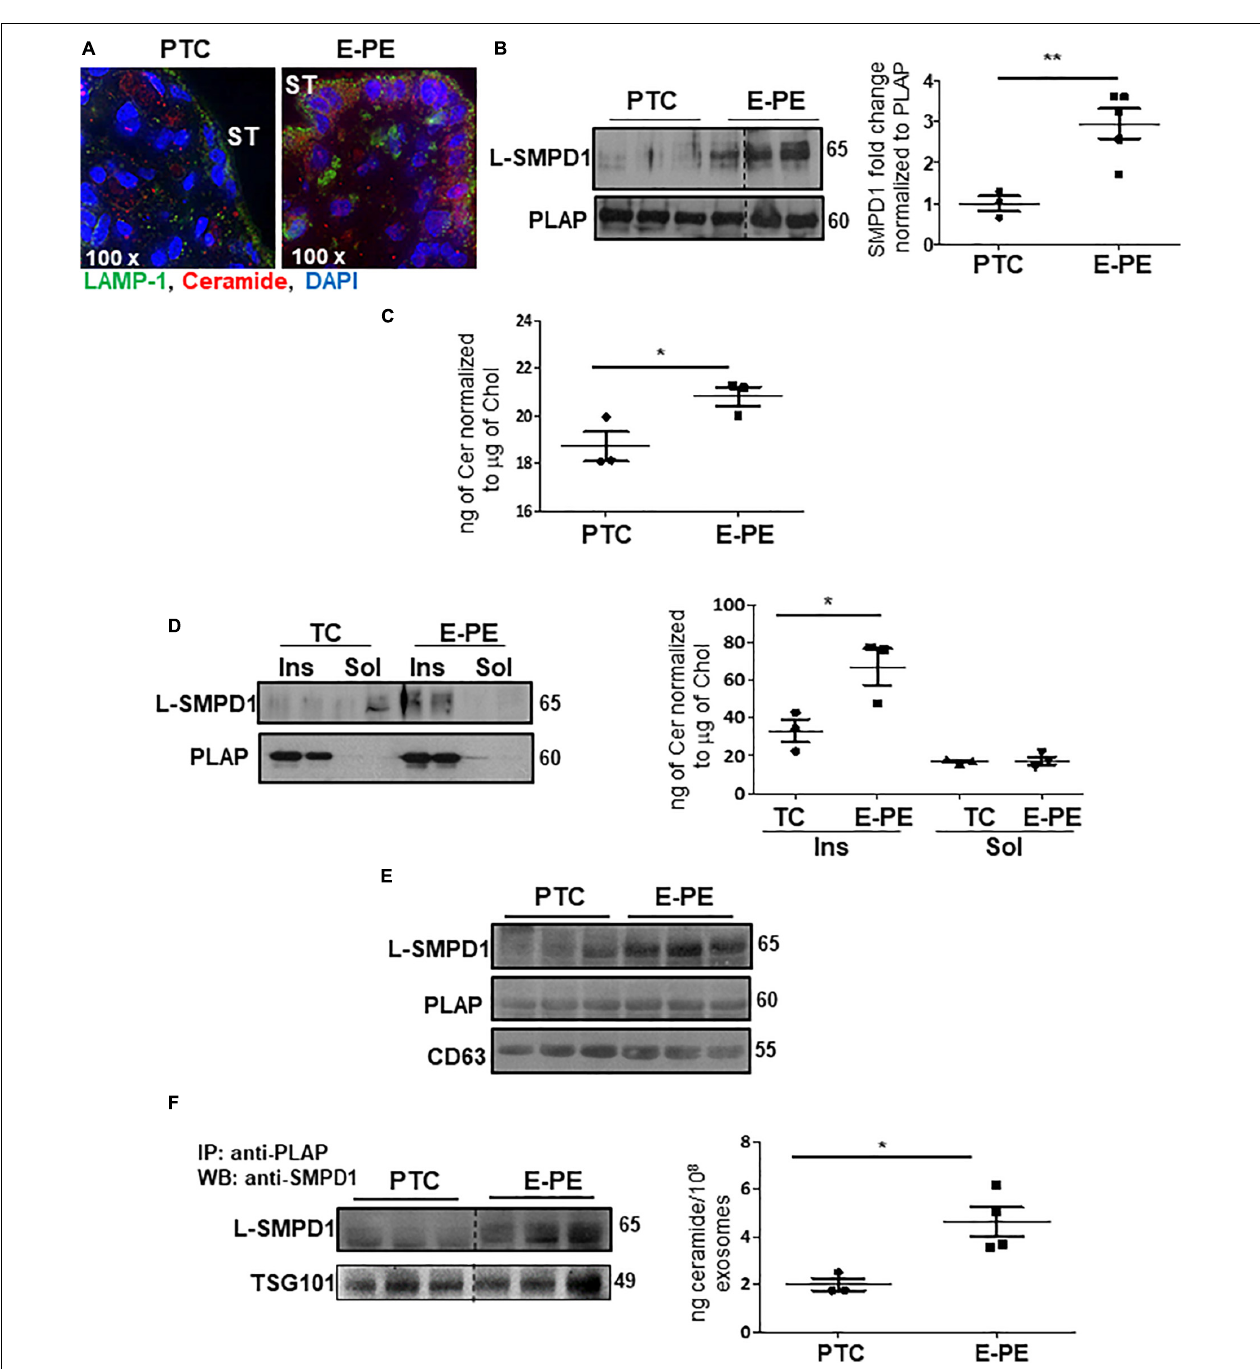
FIGURE 7 | L-SMPD1 localizes to lipid rafts of apical syncytial membranes in E-PE placentae and is released into the maternal circulation via exosomes. (A) IF images depicting LAMP-1 and ceramide localization in E-PE and PTC placentae. LAMP-1 (green); Ceramide (red); nuclear DAPI (blue). ST, syncytiotrophoblast. (B) WB and associated densitometry for L-SMPD1 in lysates of apical syncytial membranes (AM) of PTC and E-PE placentae (PTC, N = 3; PE, N = 5; ** P < 0.01 vs. PTC). PLAP was used as AM marker. (C) Total ceramide levels, measured by LC-MS/MS, in syncytial membranes extracts of TC and E-PE placentae ( N = 3 placentae per group; * P < 0.05 compared to control). ( D-left panel ) Distribution of L-SMPD1 in detergent insoluble (Ins) and soluble (Sol) fractions of AM from TC and E-PE placentae. PLAP was used as lipid raft (detergent insoluble fraction) marker. ( D-right panel ) Total ceramide levels measured by LC-MS/MS in extracts of AM Ins and Sol fractions of TC and E-PE placentae ( N = 3 samples per group; * P < 0.05 compared to TC). (E) WB for L-SMPD1, CD63 and PLAP of exosomes isolated from PTC ( N = 3) and E-PE ( N = 3) maternal plasma. (F) WB for L-SMPD1 in PLAP-precipitated exosomes from PTC ( N = 3) and E-PE ( N = 3) maternal plasma. ( F-right panel ) LC-MS/MS quantification of total ceramide in PTC and E-PE PLAP-precipitated exosomes (E-PE, N = 4; PTC, N = 3; * P < 0.05 vs. to PTC). Data are expressed as mean ± SEM. Dotted line: non-contiguous lanes run on the same gel.